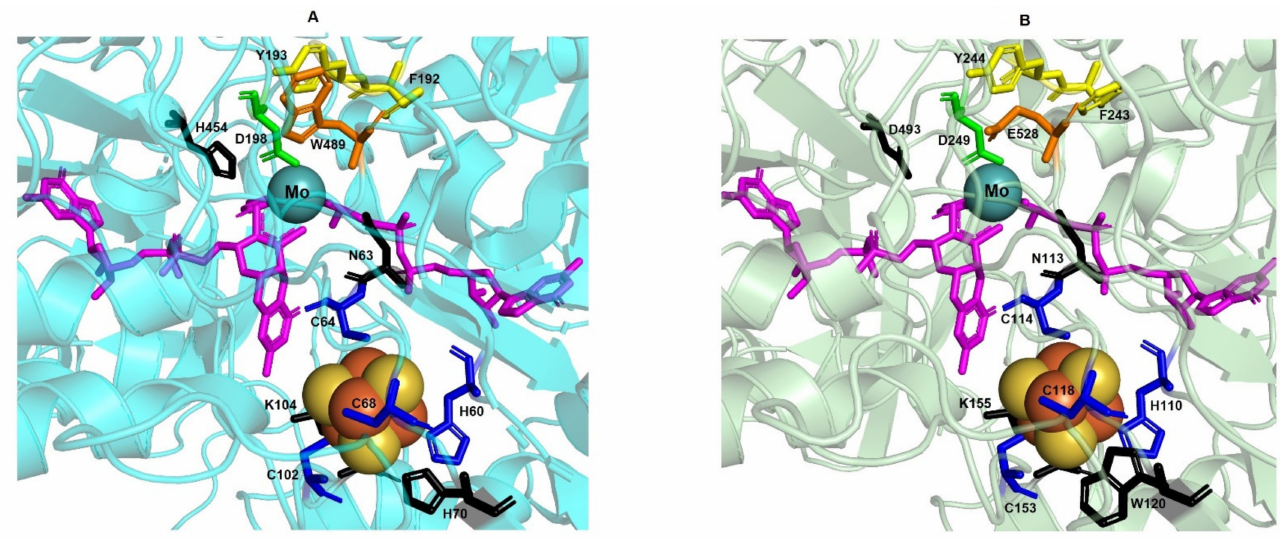
Figure 4. Crystal structure of Azospira oryzae PcrA (PDB ID: 4YDD; ( A ) and homology model of Haloferax mediterranei NarG ( B ). The PcrA and NarG catalytic subunits appear in cartoon form and are coloured in light blue and olive, respectively. Cysteines and histidine residues (dark blue sticks) involved in the coordination of the FS0 cluster (Iron and sulphur as orange and yellow spheres, respectively) are conserved in both structures. The Mo atom is a turquoise sphere and bis-MGD cofactor is represented with magenta sticks. The aspartate ligand that coordinates the Mo atom in the active site (Asp 198 and Asp 249 in PcrA and NarG, respectively) is shown as a green stick. The gate putative residues (Phe 192 and Tyr 193 in PcrA and Phe 243 and Tyr 244 in NarG) are shown as yellow sticks. Orange sticks indicate non-homologous amino acid substitution of tunnel gates (Trp 489 for PcrA and Glu 528 for NarG). Black sticks represent amino acids with possible role in substrate binding (N 63 and N 113 in PcrA and NarG, respectively), reduction potential regulation of FS0 (H 70 and W 120 in PcrA and NarG, respectively), electron transport bridge between FS0 and MOCO cofactor (K 104 and K 155 in PcrA and NarG, respectively), and proton donor during catalysis (H 454 and D 493 in PcrA and NarG,